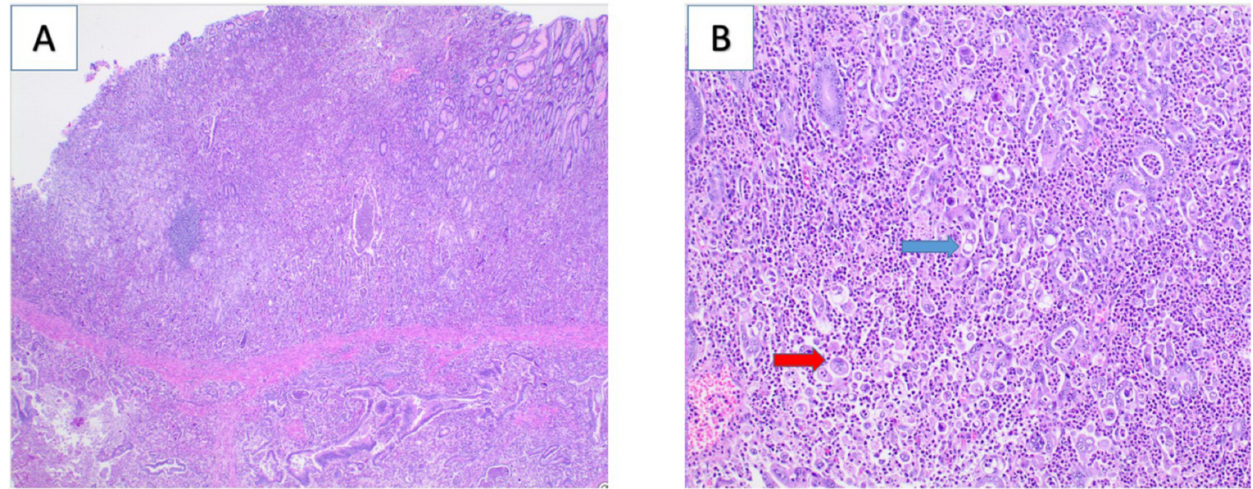
Figure 2. Hematoxylin and eosin staining revealed invasive, poorly differentiated gastric carcinoma invading into the muscularis propriawith minimal gland formation (panel ( A ),2 × magnification). Panel ( B ) (20 × magnification) demonstrates signet ring cell component (blue arrow) as well as pleomorphic neoplastic cells (red arrow).